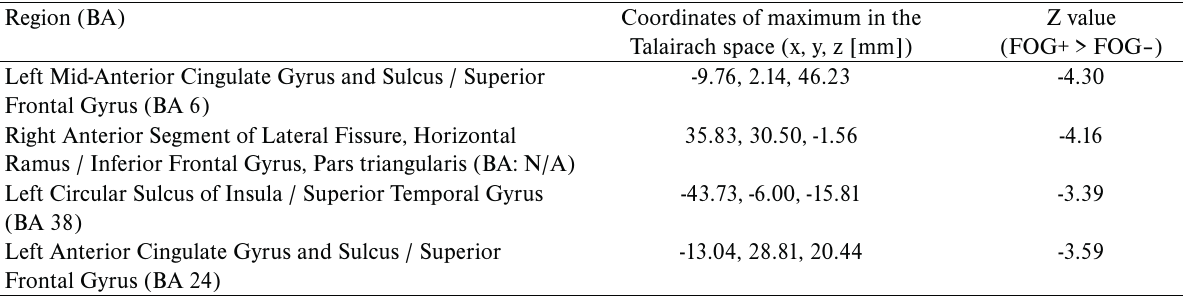
Table 4. Local maxima of vertex-wise differences in cortical thickness.